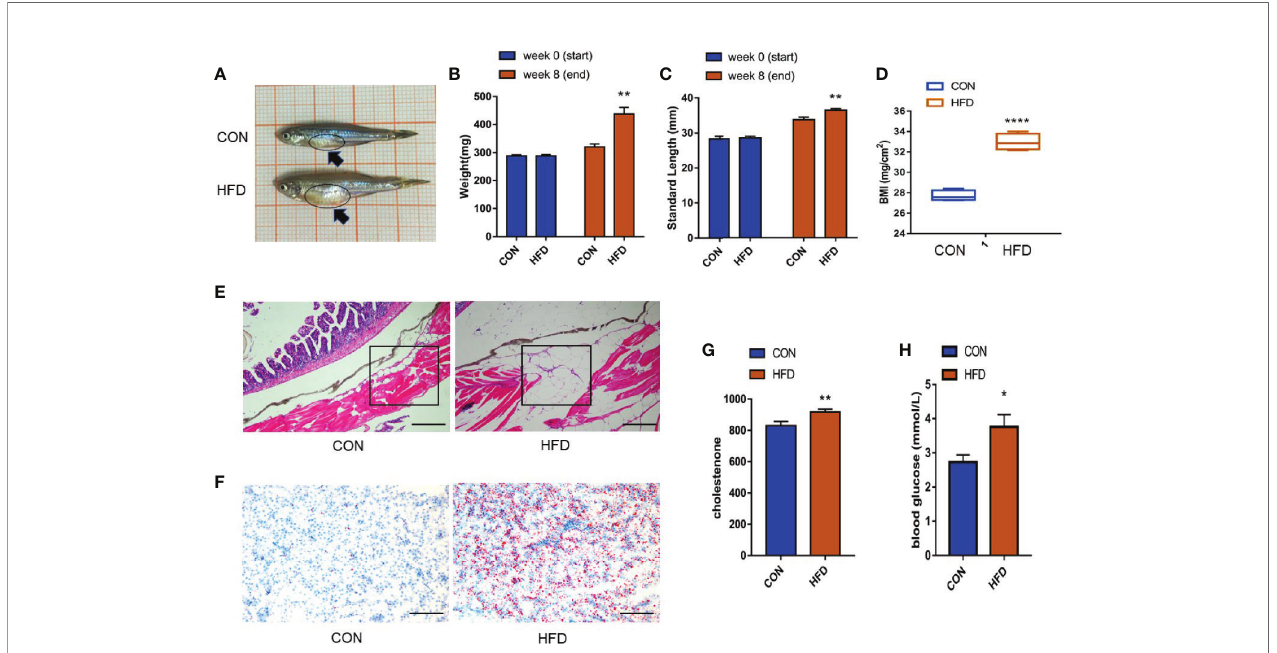
FIGURE 1 | Successful establishment of the obesity model. (A) Male zebra fi sh appearance in control and obese groups. A clearly larger abdomen can be seen in zebra fi sh in the obese group as shown by the dark blue arrow. (B, C) Measurement of body weight and length of zebra fi sh before and after exposure. (D) Signi fi cant differences in the BMI index. (E) Expression of subcutaneous fat in zebra fi sh (scale bar = 100 m m). (F) Expression of fat droplets in the liver (scale bar = 100 m m). (G, H) Determination of cholesterol in the blood and detection of blood glucose. Values are mean ± SME (n = 5). The asterisk represents a statistically signi fi cant difference when compared with the controls; *, ** and **** at P < 0.05, P < 0.01 and P < 0.0001,